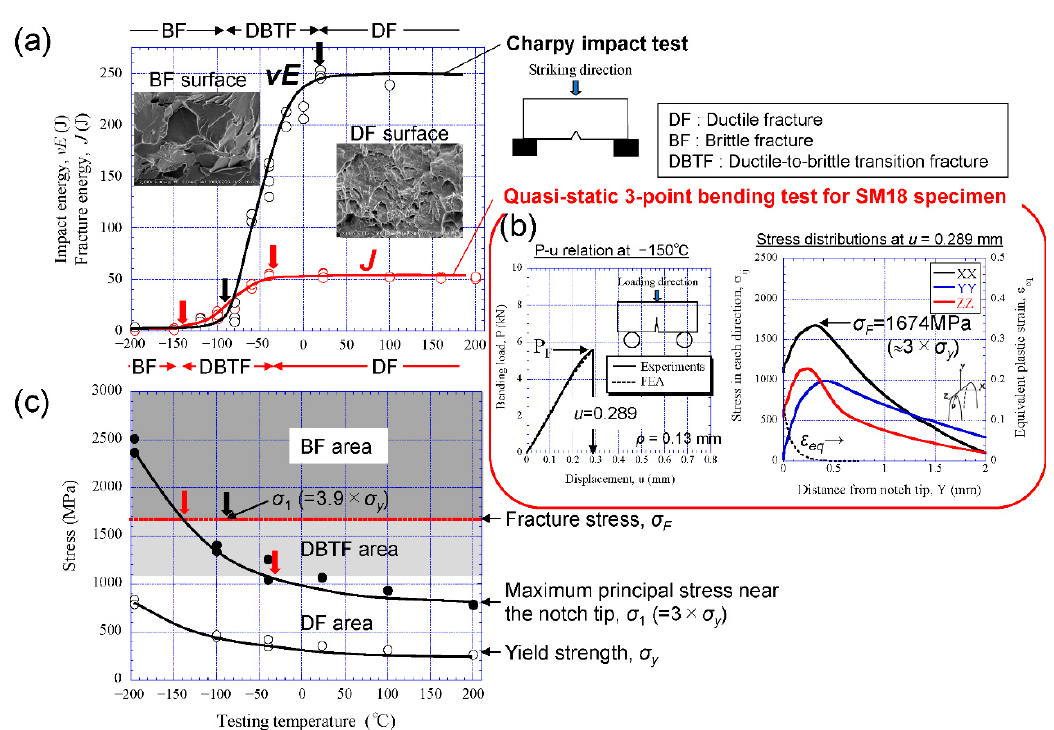
Figure 14. Variations in the ( a ) fracture energy and ( c ) stress with temperature for the SM18 sample, where ( a ) vE denotes the Charpy impact absorbed energy [11] and J denotes the fracture energy obtained in the three-point bending test shown in Figure 2a [20], and ( c ) σ 1 denotes the maximum tensile stress near a notch tip and is about 3 times σ y under the present bending test. ( b ) Comparison between the P - u relations at − 150 °C obtained via experiments and FEA and distributions of the stresses and the equivalent strain ε eq near the initial notch tip at u = 0.289 mm obtained via FEA.